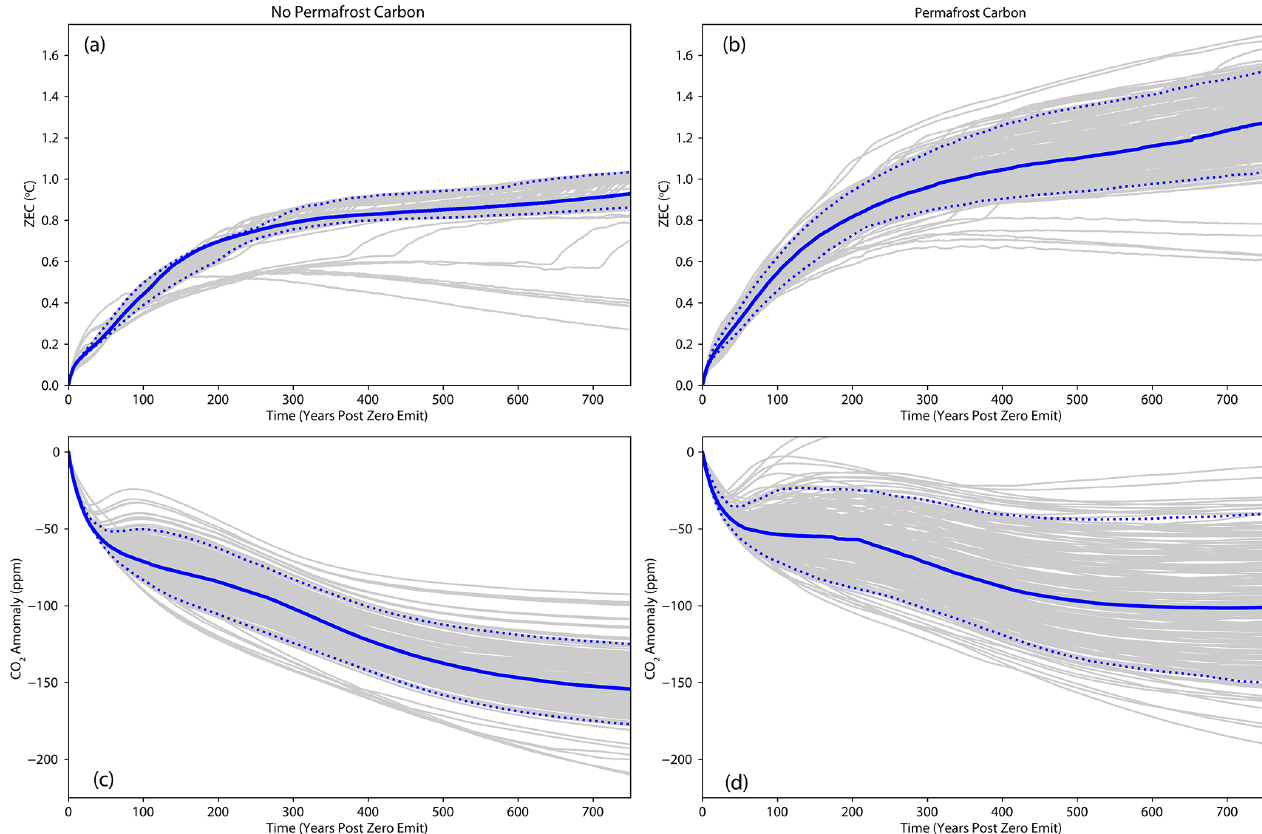
Figure 8. (a, b) Zero Emission Commitment (ZEC) for model versions without (a) and with (b) a permafrost carbon pool forced by the 2000PgC A3 experiment. ZEC is temperature change relative to the year emissions cease. (c, d) Change in atmospheric CO 2 concentra- tion relative to year emissions cease for model versions without (c) and with (d) a permafrost carbon pool forced by the A3 (2000PgC) experiment. Grey lines are individual model variants, solid line is the median of the variants, and dashed lines are the 5th and 95th